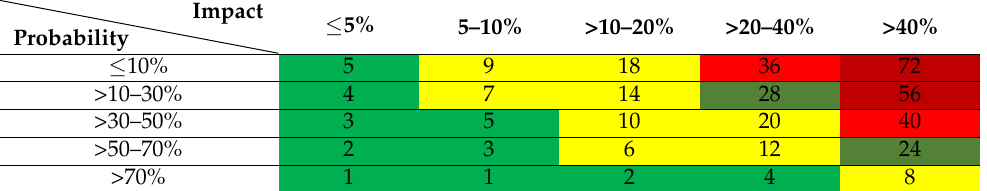
Table 8. Probability and risk impact matrix in the PRA program [53,54].